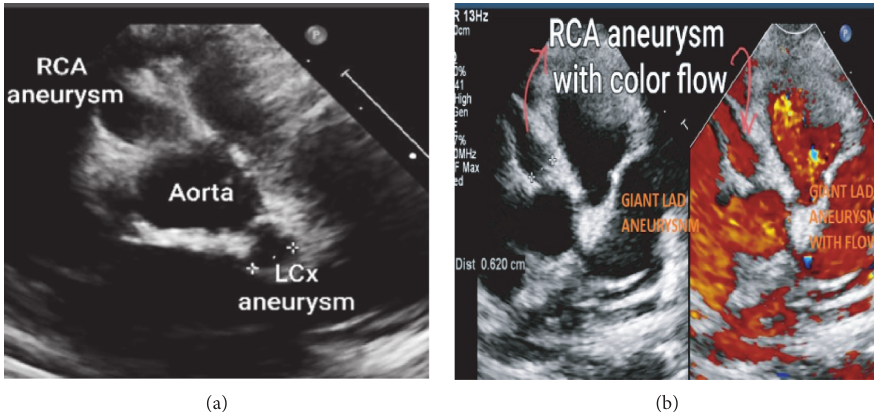
Figure 5: (a) Echocardiography still image showing left and right coronary aneurysms. (b) Echocardiography with color flow still image showing left and right coronary aneurysms.